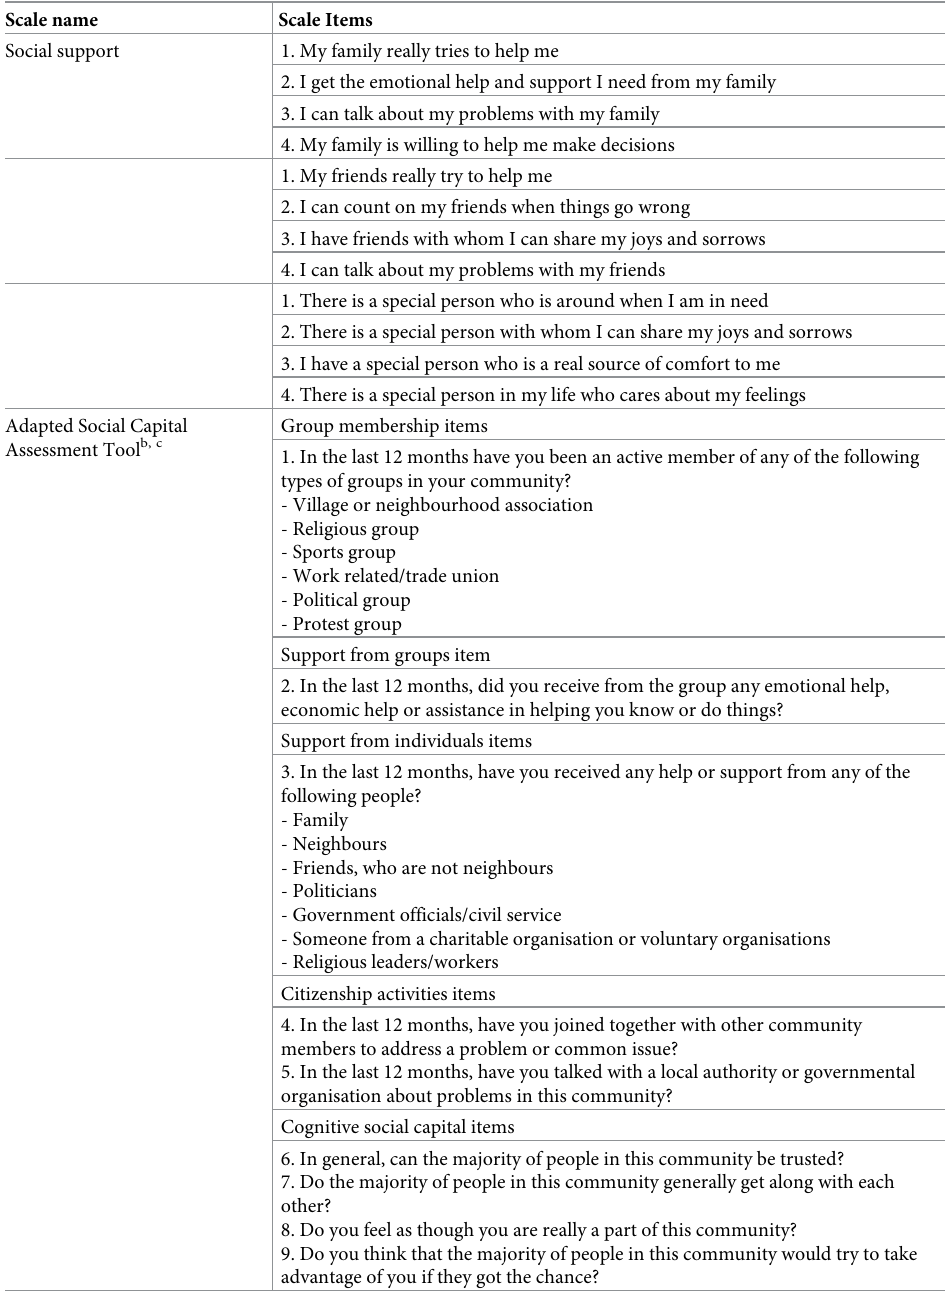
Table 3. Additional measures used in Study